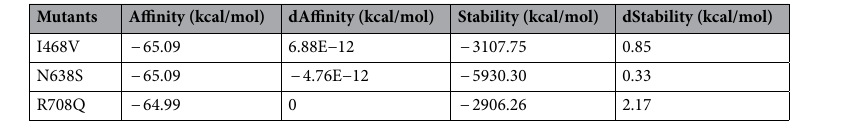
Table 2. Analysis of affinity and stability of polymorphism in ACE2 from local population binding to spike protein of SARS-COV-2.